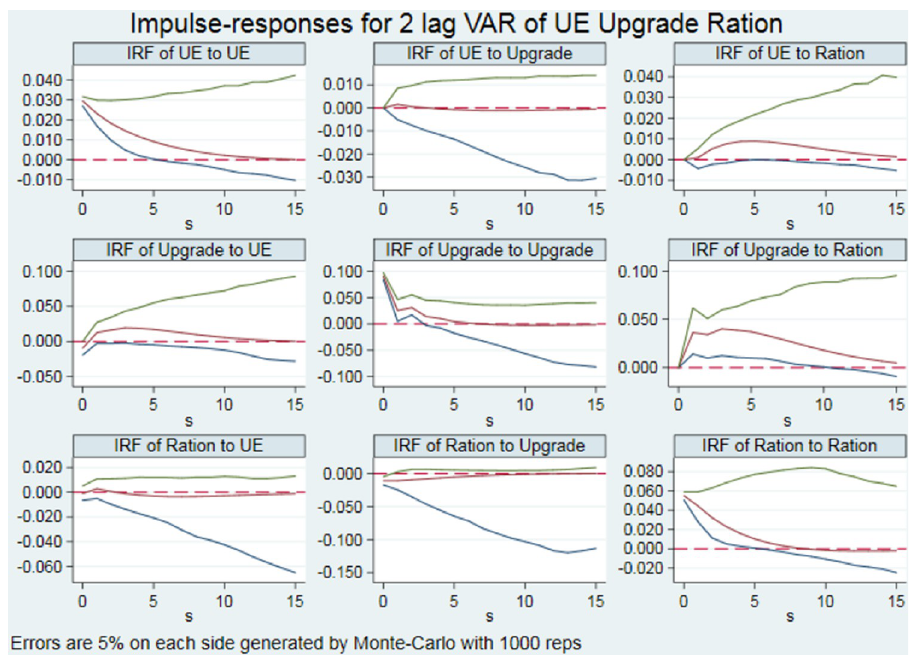
Fig 2. Results of impulse